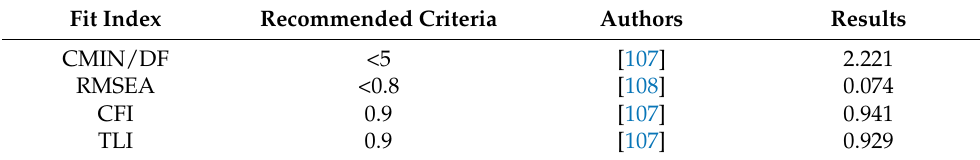
Table 2. Final measurement model fit indices.